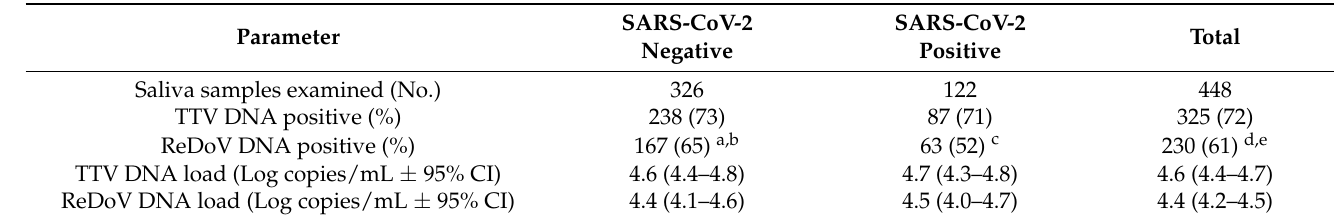
Table 1. TTV and ReDoV prevalence and load in the saliva samples, grouped by SARS-CoV-2 RNA